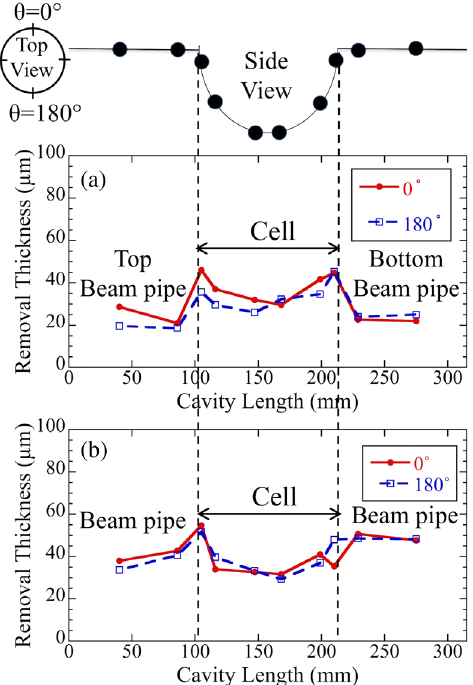
FIG. 7. Trends of the removal thicknesses along the cavity length in the VEP (a) and HEP (b)